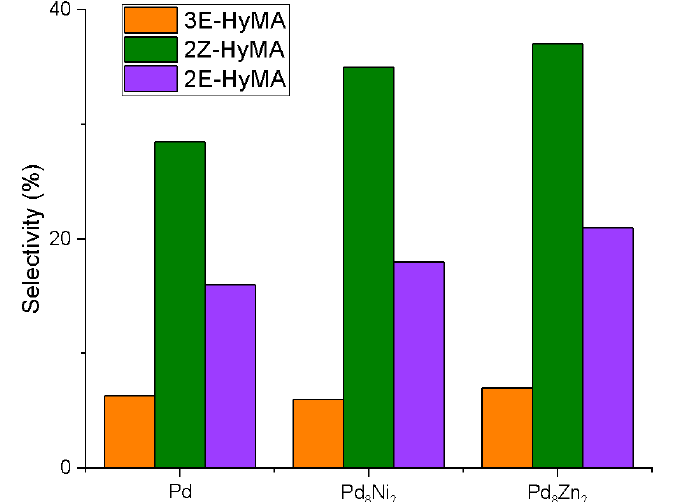
Figure 2. Scheme of MA (left) and Na-muconate (right) conversion to AdA.